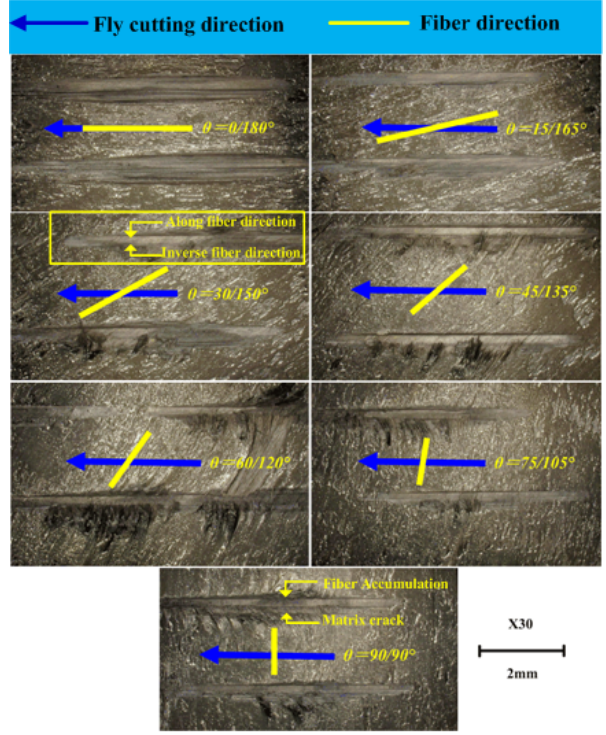
Figure 9. Macroscopic fracture morphology in prepreg fly cutting with PCD tools.